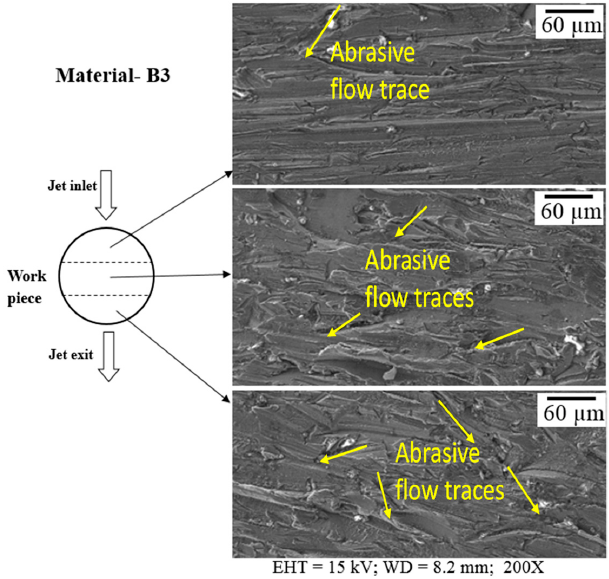
Figure 7. Surface along the depth of sample B3 after machining.